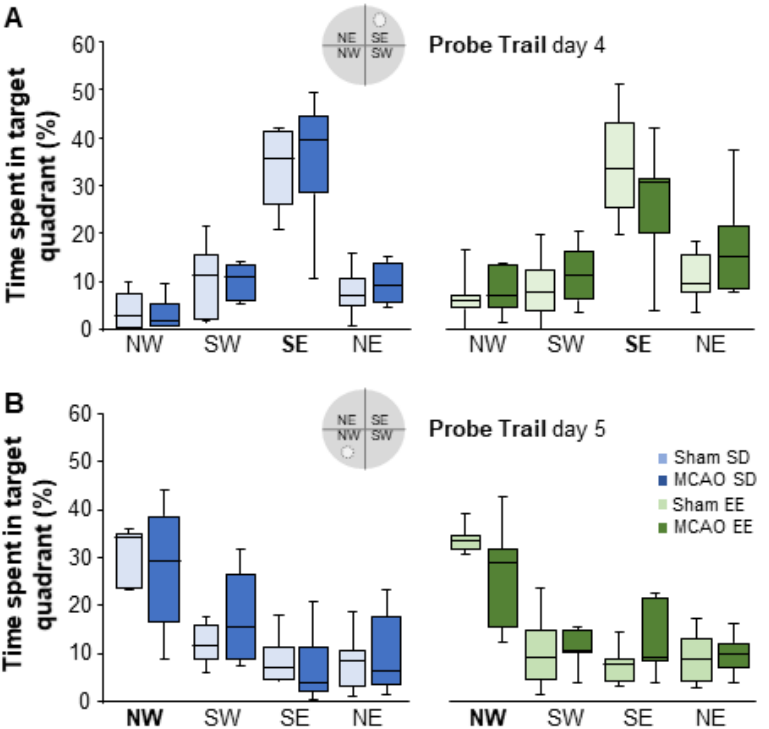
Figure 8. The trial was conducted on ( A ) day 4 (before the platform change) and ( B ) day 5 (after the platform change). The platform was removed from the pool for the probe trail, and the time spent in the different quadrants was determined. ( A ) All animals learned the first platform position in the quadrant SE without significant differences between the groups. ( B ) On day 5, all groups showed a higher preference for the new platform position. There was no impairment in spatial learning during the probe trial. The boxplots show the median, the upper and lower quartiles and the minimum and maximum values. The analysis was performed with the Mann-Whitney U test, all p - and n -values. SD = standard housing; EE = enriched environment